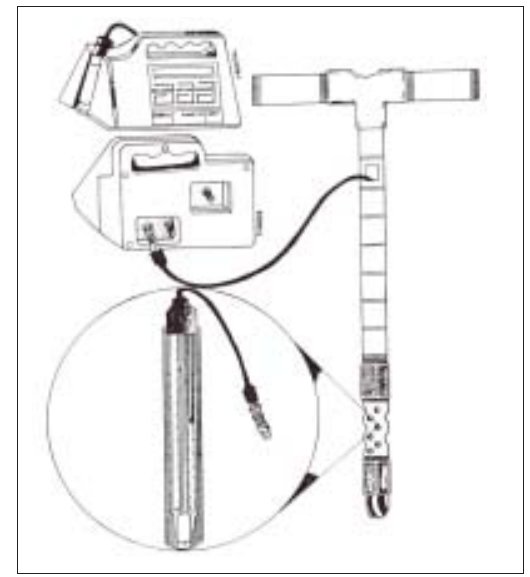
Figura 1. Equipamento adaptado para leitura de pE e pH em campo, destacando-se a ponteira para a proteção do eletrodo que foi revestido com tela de